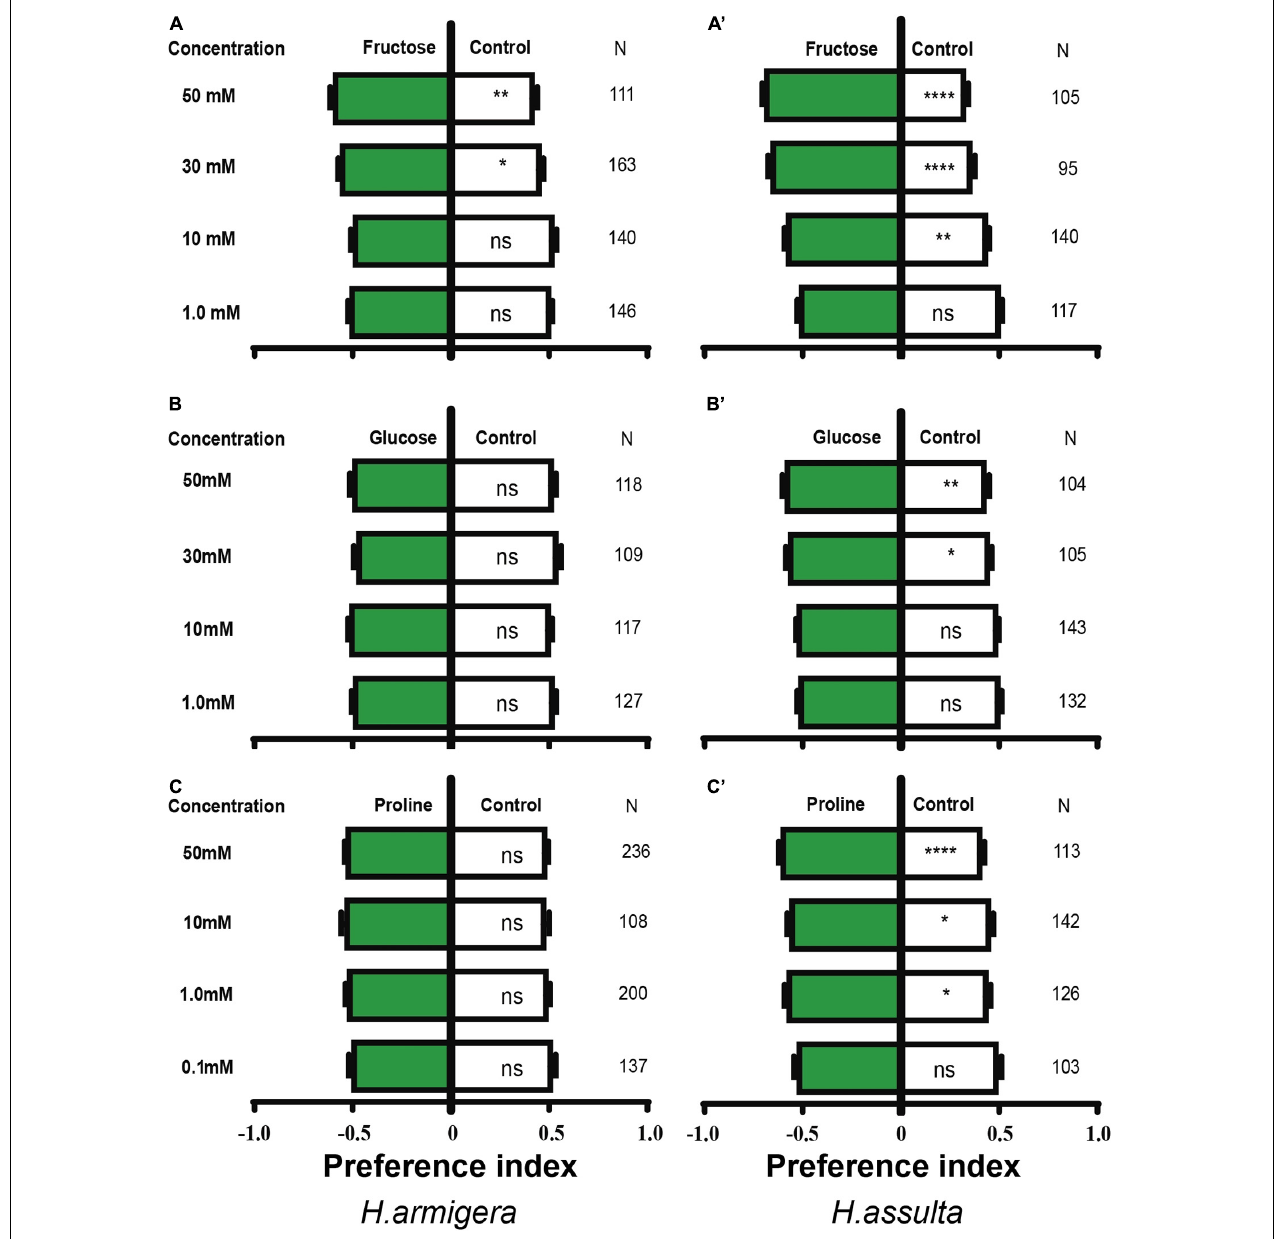
FIGURE 4 | Effects of three primary metabolites on the feeding preferences of Helicoverpa caterpillars. The preference indexes of caterpillars for primary metabolites (green bars) and for control leaves (white bar) were compared. The dual-choice assay was used to test the feeding preference for control and pepper leaves treated by primary metabolites and water, respectively. (A–C) : H. armigera caterpillars; (A’–C’) : H. assulta caterpillars. A paired-sample t -test was used to compare the means of the preference indices between treatment and control. “*,” “**,” and “****” represent that the difference was significant at 0.05, 0.01, and 0.0001 levels, respectively. NS: non-significant difference. N: the number of tested